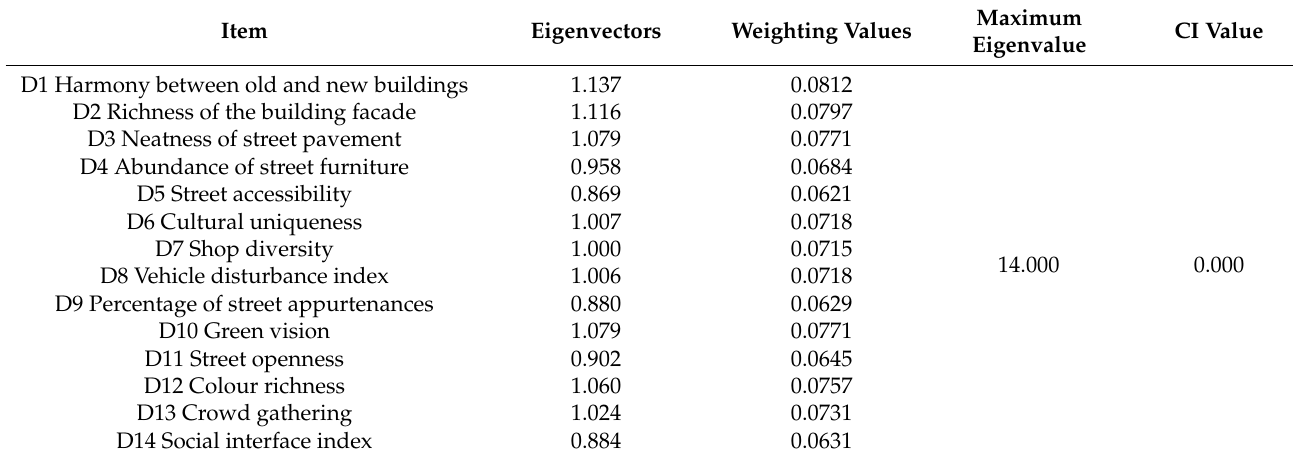
Table 5. AHP indicator description weighting